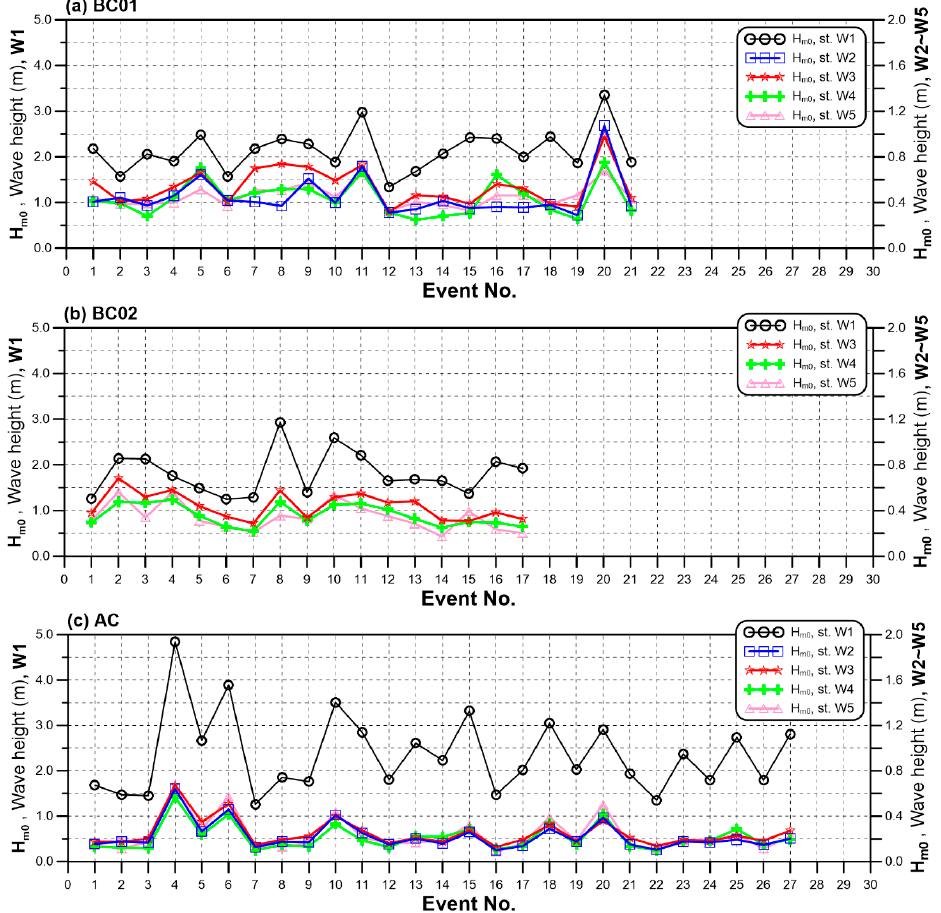
Figure 5. ( a ) Maximum values of H m 0 observed in the 21 events before construction in W1 (black circles), W2 (blue squares), W3 (red stars), W4 (green crosses), and W5 (pink triangles) for BC01 (15 October 2008~12 July 2009); ( b ) maximum H m 0 values for the 17 events before construction in W1 (black circles), W3 (red stars), W4 (green crosses), and W5 (pink triangles) for BC02 (21 May 2018~13 February 2019) (it is noted that the H m 0 in W2 was not included due to poor data quality); ( c ) maximum H m 0 values for the 27 events after the construction in W1 (black circles), W2 (blue squares), W3 (red stars), W4 (green crosses), and W5 (pink triangles). The pattern of H m 0 variation